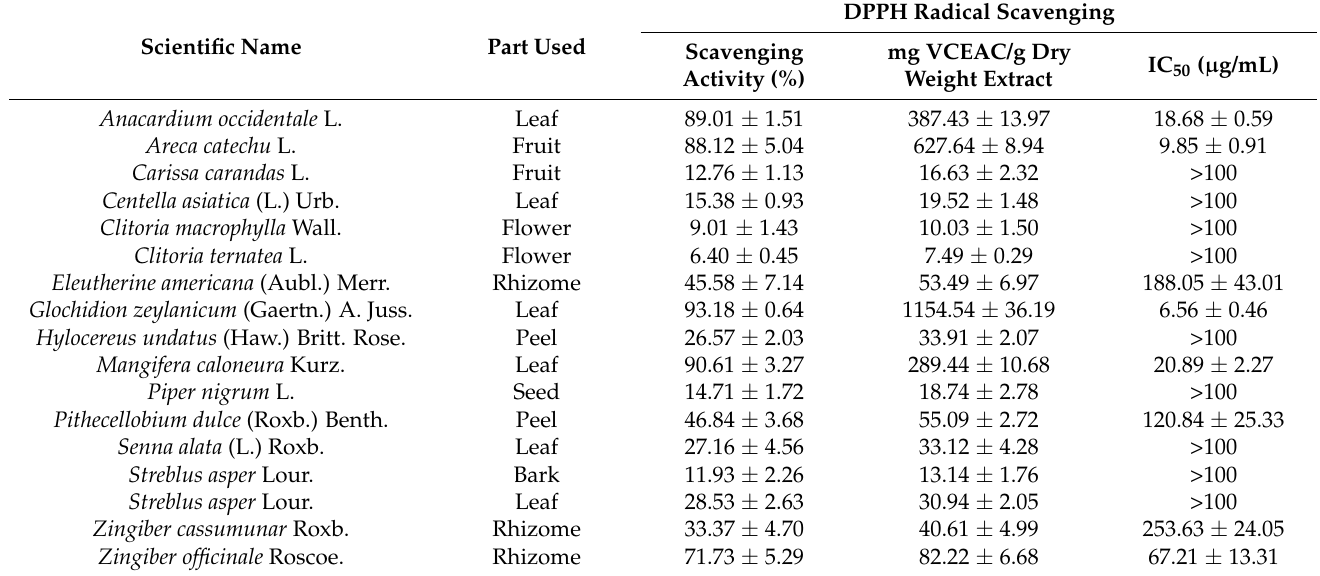
Table 3. DPPH radical scavenging activity of Thai